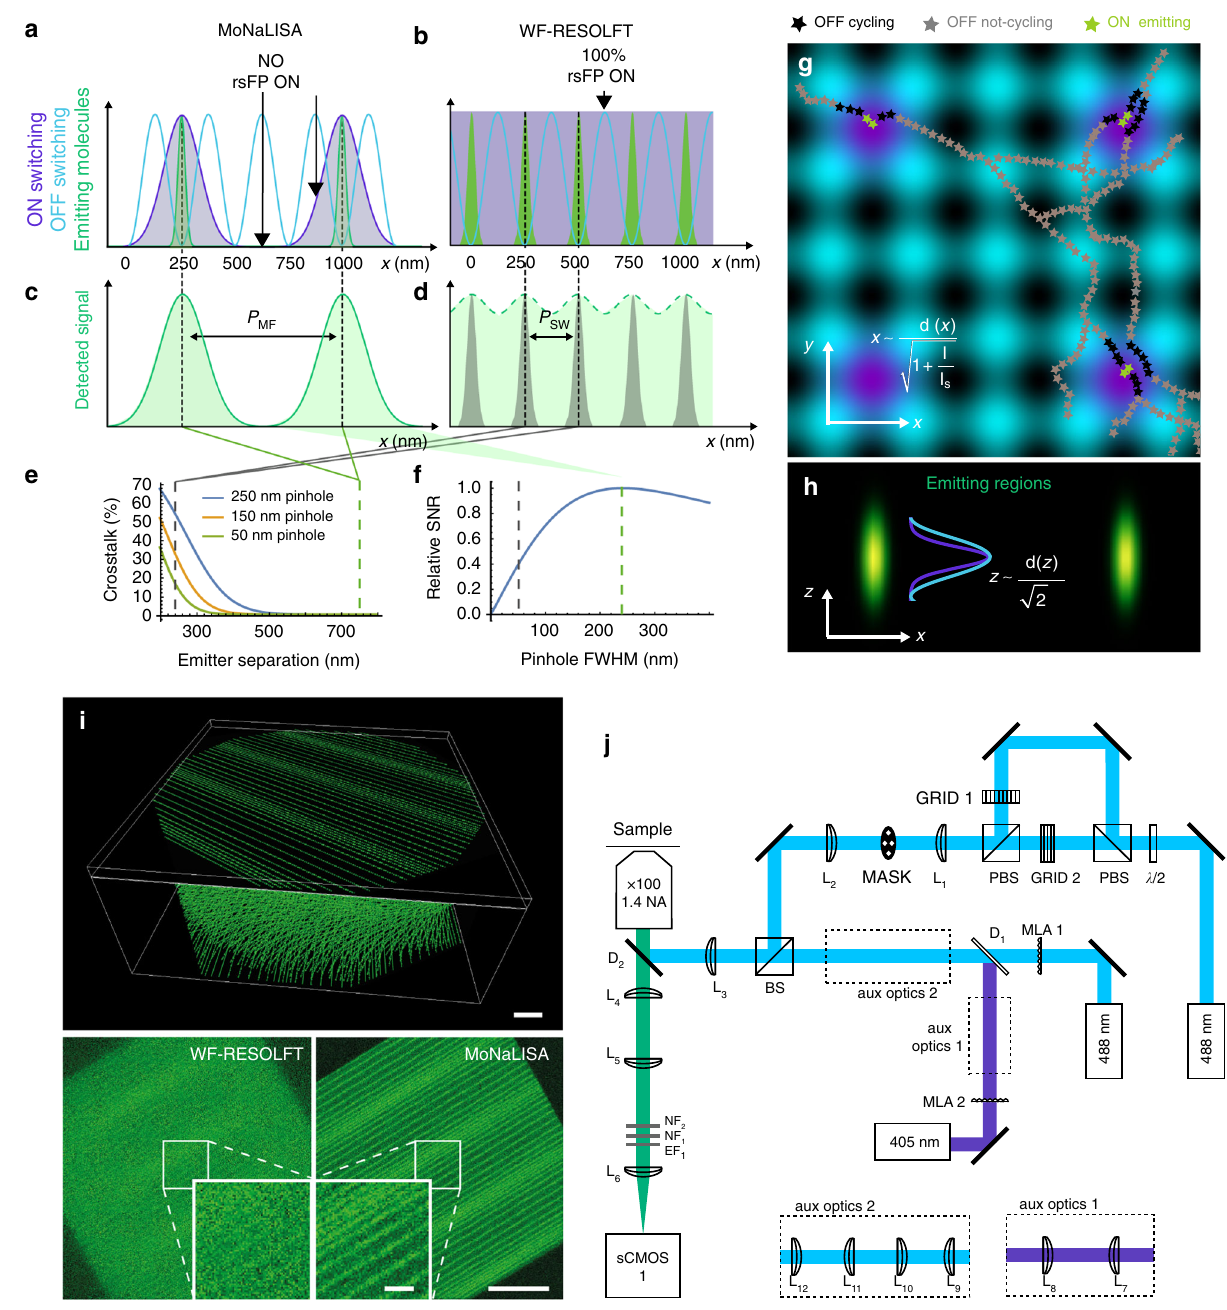
Fig. 1 Basic concept and imaging scheme. 1D representation of MoNaLISA ( a ) and wide- fi eld RESOLFT ( b ) illuminations. The ON-switching (violet) and the excitation are multiple Gaussian foci (periodicity P MF ) in MoNaLISA and homogenous in WF-RESOLFT. The OFF-switching light (blue, periodicity P SW ) con fi nes the fl uorescence emission (green). Detected fl uorescence distributions for MoNaLISA ( c ) and WF-RESOLFT ( d ) as green area. e The larger foci separation P MF > P SW in MoNaLISA allows detection of the whole fl uorescence signal without crosstalk. f Fluorescence collection ef fi ciency for different sizes of digital pinholing. MoNaLISA 250 nm optimal size (green dashed line) increases photon collection and SNR compared to the 50 nm pinholing of WF-RESOLFT (gray dashed line). g 2D calculation of the MoNaLISA illumination: ON-switching and excitation (violet), OFF-switching (blue). Filaments showing rsFPs in different states are illustrated. MoNaLISA minimizes ON – OFF cycling since most of rsFP facing OFF light maxima are in the OFF state. Scale bars, 250nm. h The fl uorescence con fi nement is extended in 3D as shown in the x – z section. Scale bars, 250 nm. i Simulations show that the combination of increased photon collection, saving rsFP switching cycles and 3D con fi nement of MoNaLISA images allow imaging of structures which are not observed in WF-RESOLFT. The simulated structure is composed of straight lines with varying separation (~80 – 300 nm) in planes separated by 300 nm along the optical axis. Scale bars, 1 μ m (top), 2.5 μ m (large bottom), and 500 nm (zoom inset). j Schematic representation of the optical set-up. MLA 1, MLA 2: microlens arrays, GRID 1, GRID 2: diffraction gratings, PBS polarizing beam splitter, BS non-polarizing beam splitter with 90/10 or 50/50 re fl ection/transmission, MASK custom-built mask to let through only the orders 1 and − 1 of the two orthogonally polarized beams, NF notch fi lter, EF emission fi lter, and D dichroic mirror. L1: f = 100 mm, L2: f = 300 mm, L3: f = 300 mm, L4: f = 250 mm, L5: f = 250mm, L6: f = 200 mm, L7: f = 200 mm. Aux optics 1. L9: f = 200 mm, L10: f = 150 mm, L11: f = 250 mm, L12: f = 250 mm. Aux optics 2. L7: f = 100 mm, L8: f = 100